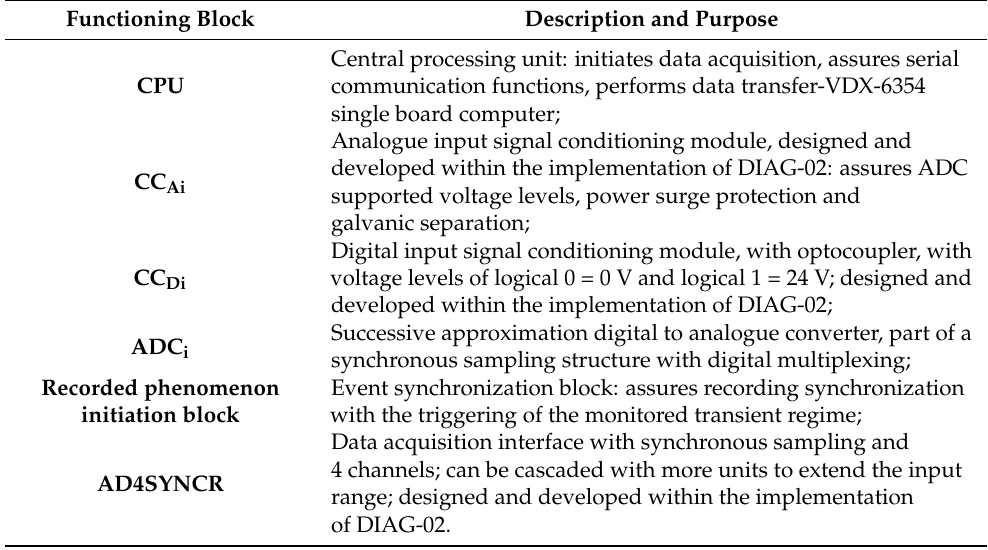
Table 1. Main hardware components of the acquisition